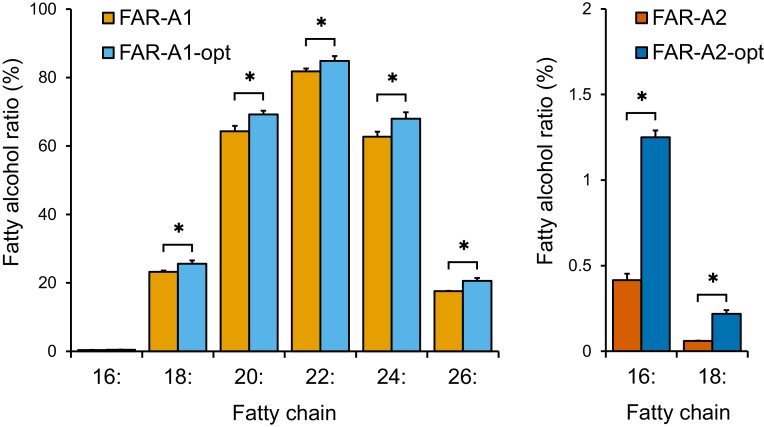
Apparent specificity of FARs expressed from wild-type and yeast codon-optimized sequences.Plasmids carrying wild-type and yeast codon-optimized (‘-opt’) nucleotide sequences for two FARs from B. lucorum, BluFAR-A1 and BluFAR-A2, were transformed into yeast host and expressed (N = 3). Fatty alcohol production was analyzed by GC of yeast total lipid extracts. The fatty alcohol ratios represent the apparent specificity of expressed FARs. Significant differences (p < 0.05, two-tailed t-test) are marked with an asterisk. See Equation 1 for a description of fatty alcohol ratio calculation.